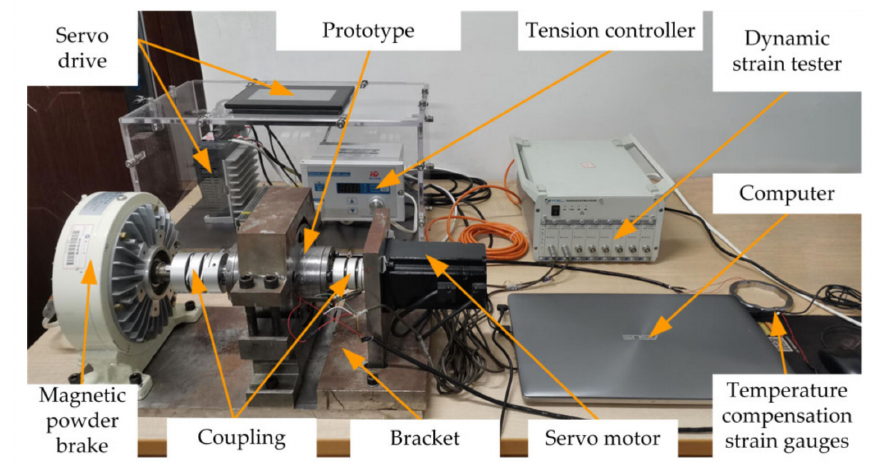
Figure 13. Figure of the overall installation of strain test